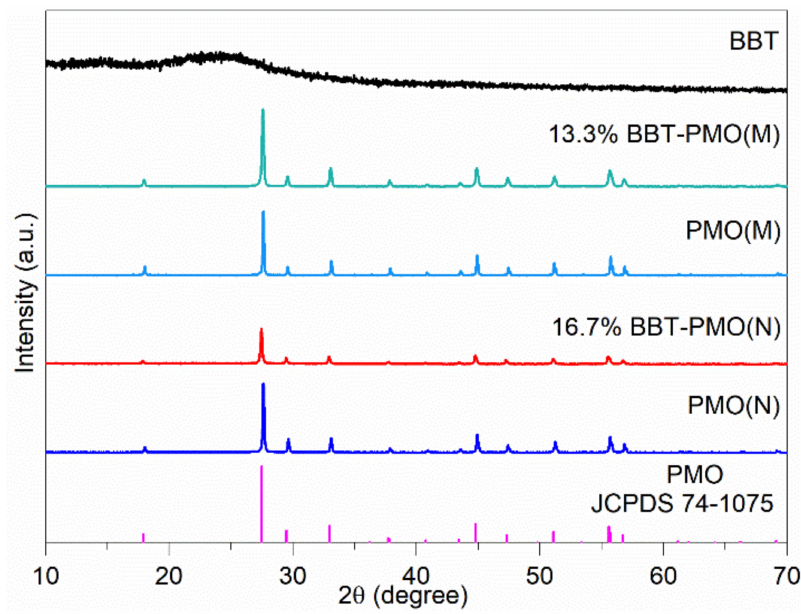
Figure 3. XRD patterns of BBT, 13.3% BBT-PMO(M) and PMO(M), and 16.7% BBT-PMO(N) and PMO(N). The existence of the BBT component in the BBT-PMO was confirmed by Raman spectroscopy. As shown in Figure 4, the characteristic peaks of BBT at 1364 and 1537 cm − 1 corresponded to the C–C skeleton stretching vibration and that of the aromatic ring in BBT, respectively [7,13]. The peaks around 260, 756, and 860 cm − 1 could be assigned to the bending vibrations of different components of the MoO 4 tetrahedron [25]. The peaks of the BBT-PMO sample covered both BBT and PMO. This indicated that BBT was successfully loaded onto the PMO powder, which was verified to be a heterojunction form in the following analysis.